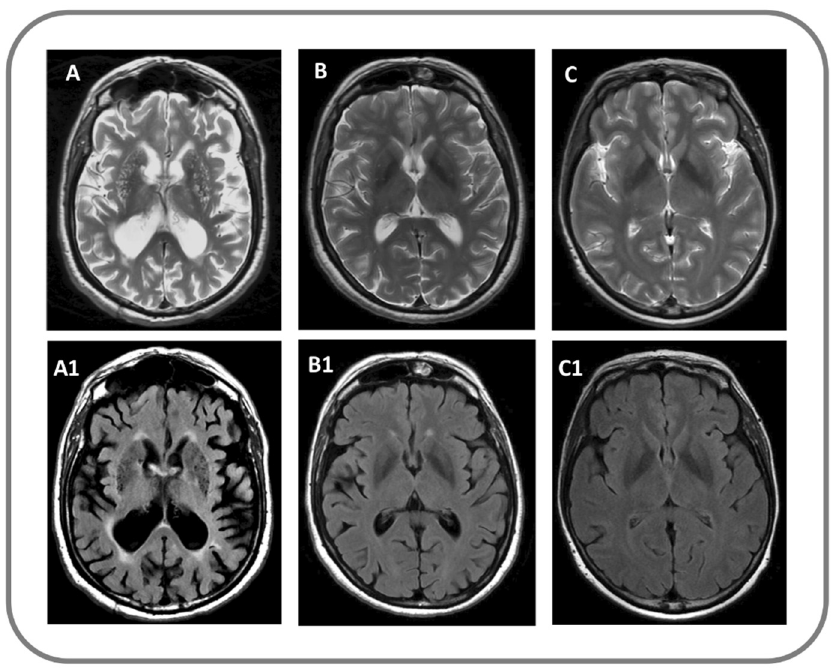
Figure 2. Findings on conventional structural MRI in a patient with VP ( A , A1 ), with PD ( B , B1 ) and in a control subject ( C , C1 ); ( A – C ) panels: T2-weighted image; ( A1 – C1 ) panels: Fluid attenuated in- version recovery (FLAIR) image. inversion recovery (FLAIR)